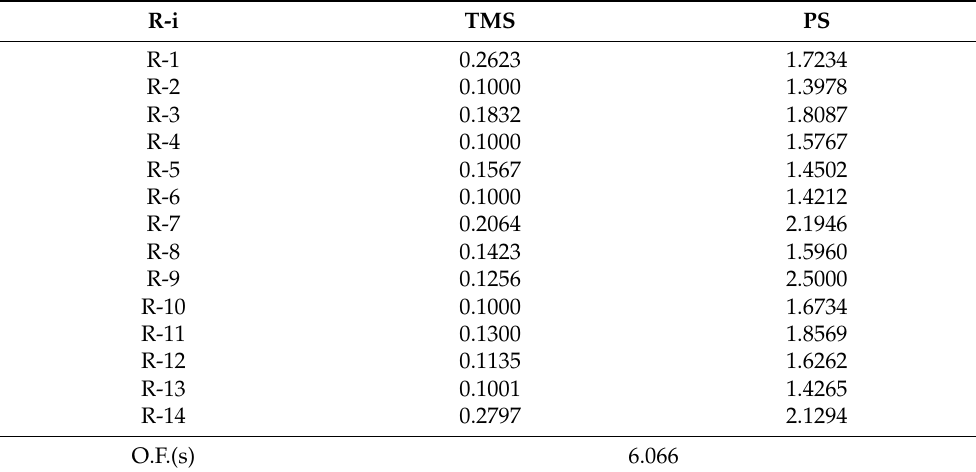
Table 4. Optimal values of time multiplier settings (TMS) and plug settings (PS) by MHHO (8- Bus